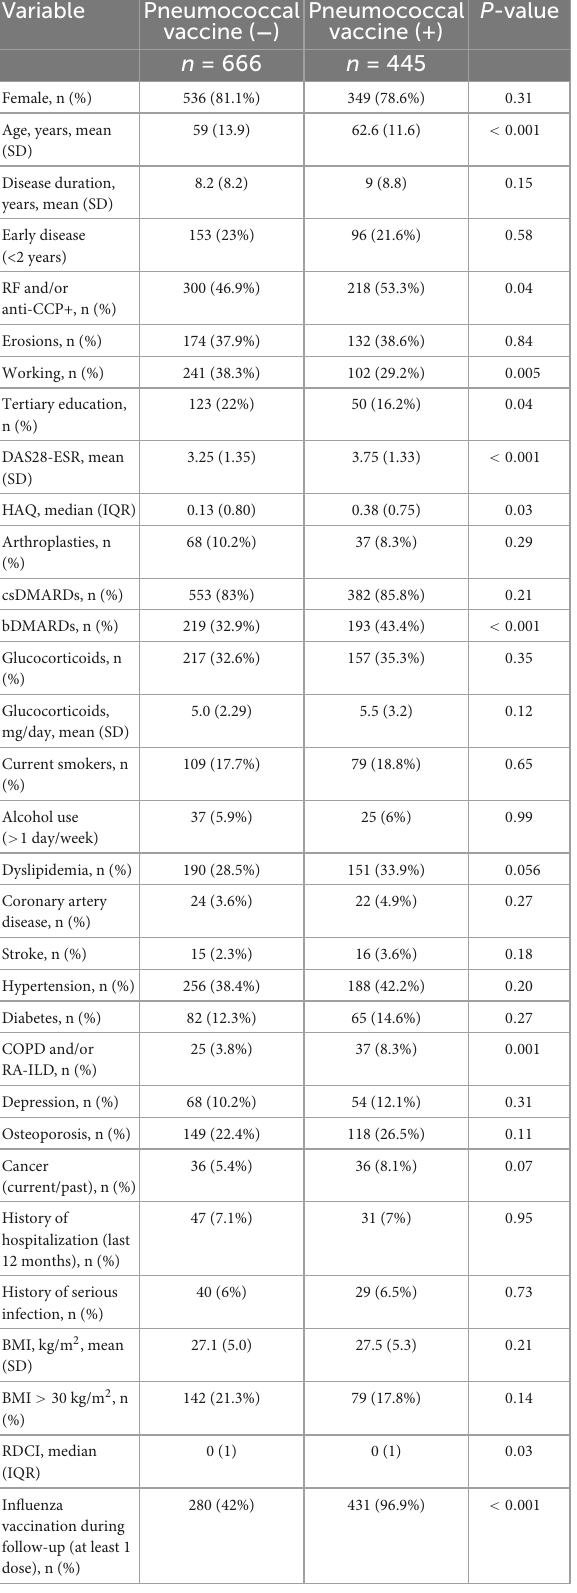
TABLE 3 Comparison of patients who were vaccinated during follow up ( n = 445) vs. those who remained non-vaccinated ( n = 666).